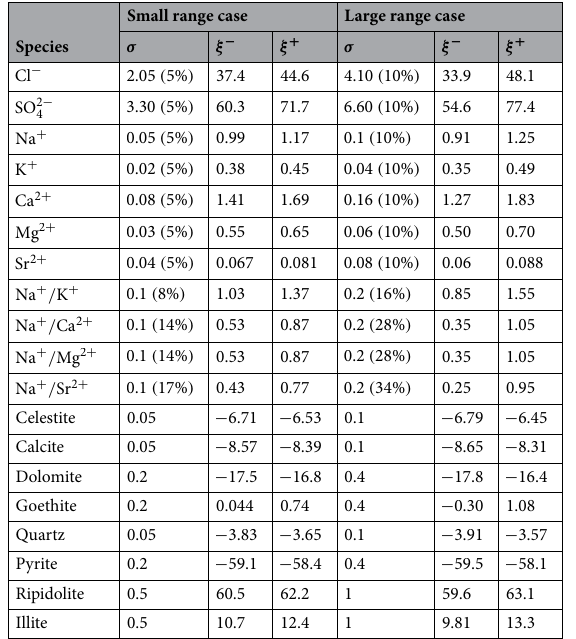
Table 2. Standard deviation σ , minimal value ξ − and maximal value ξ + of the 19 uncertain input parameters for the small range case and the large range